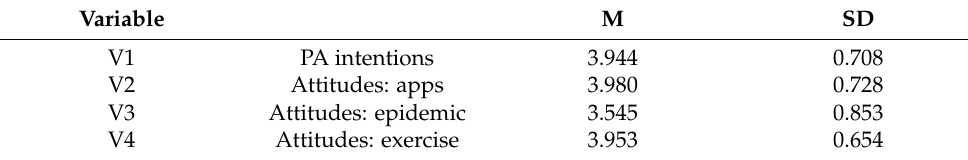
Table 2. Descriptive statistics and correlation coefficients of key